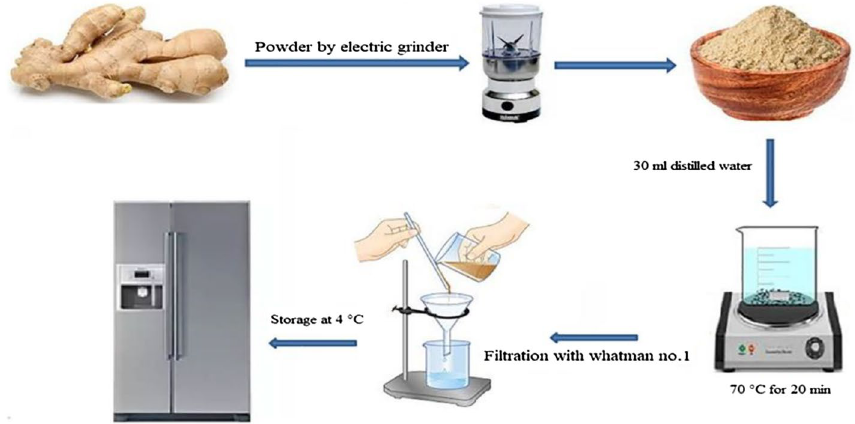
Figure 4. The synthesis scheme of extraction of ginger.